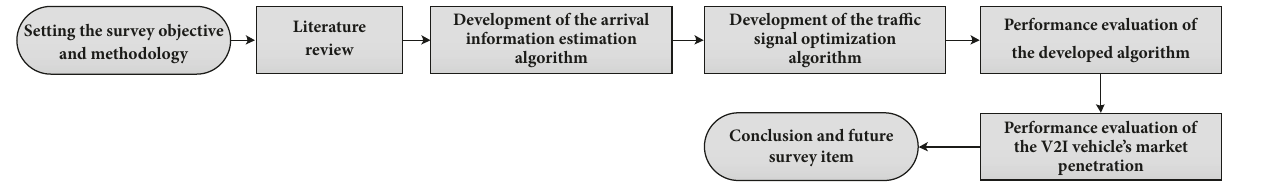
Figure 1: Research